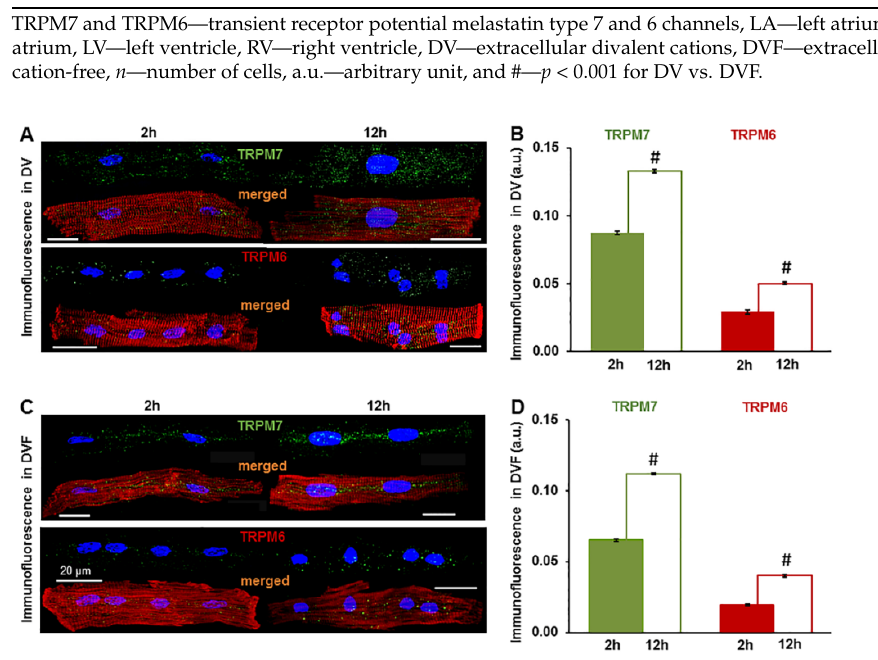
Figure 2. Comparison of the expression of TRPM6 and TRPM7 in left ventricular cardiomyocytes incubated for 2 h vs. 12 h in extracellular solutions with ( A , B ) and without ( C , D ) divalent cations (DV and DVF, respectively). ( A , C ) The cardiomyocytes were fixed after 2 h (filled columns) or 12 h (unfilled columns) of cell isolation: Alexa Fluor 488 for the TRPM7 and TRPM6 proteins (stained in green), Alexa Fluor 546 for the F-actin cytoskeleton (stained in red), and Hoechst 33342 for the nuclei (stained in blue). Scale bars indicate 20 µ m. ( B , D ) Quantification of the intensity of the fluorescence expressed in arbitrary units (a.u.). # p < 0.001 expression after 12 h vs. 2 h of cardiomyocyte